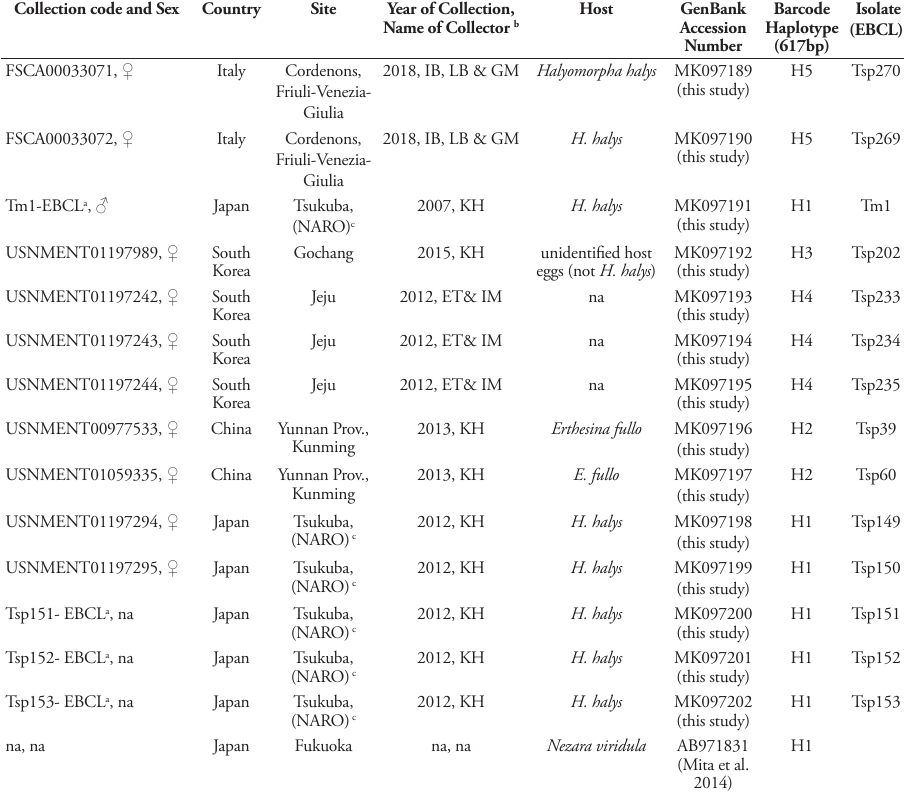
Table 3. Sampling Information, GenBank Accession numbers and haplotypes for Trissolcus mitsukurii included in this